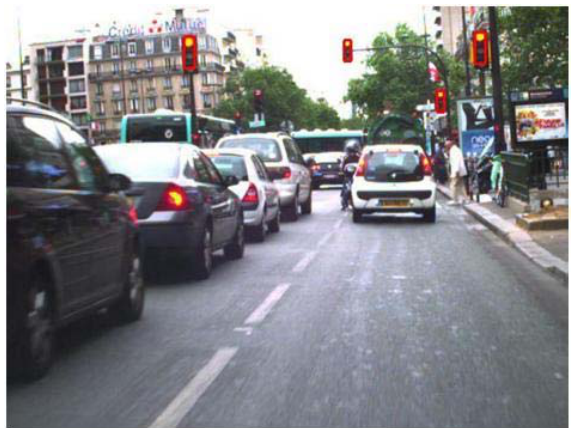
Fig. 6. Result image of the whole traffic lights recognition algorithm. All four traffic lights in status “stop” are recognized correctly without false alarms and labeled with the red